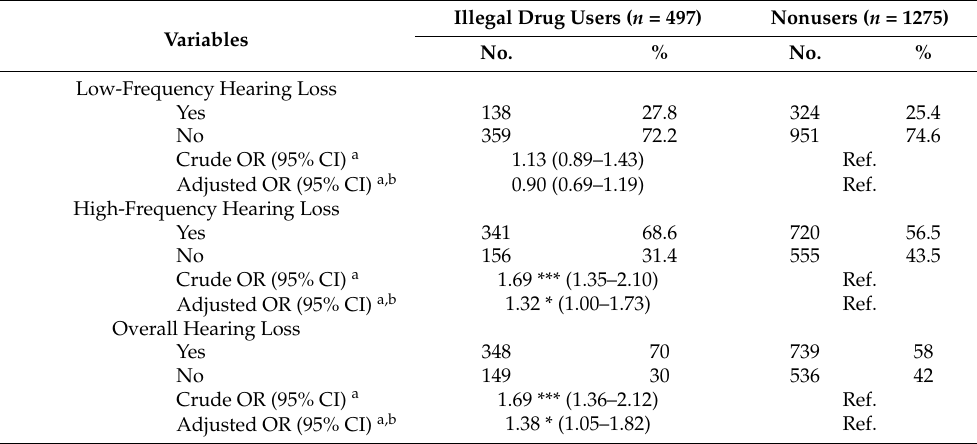
Table 2. Prevalence, odds ratios, and 95% confidence interval for low-frequency hearing loss, high- frequency hearing loss, and hearing loss, stratified by whether or not patients used illegal drugs.